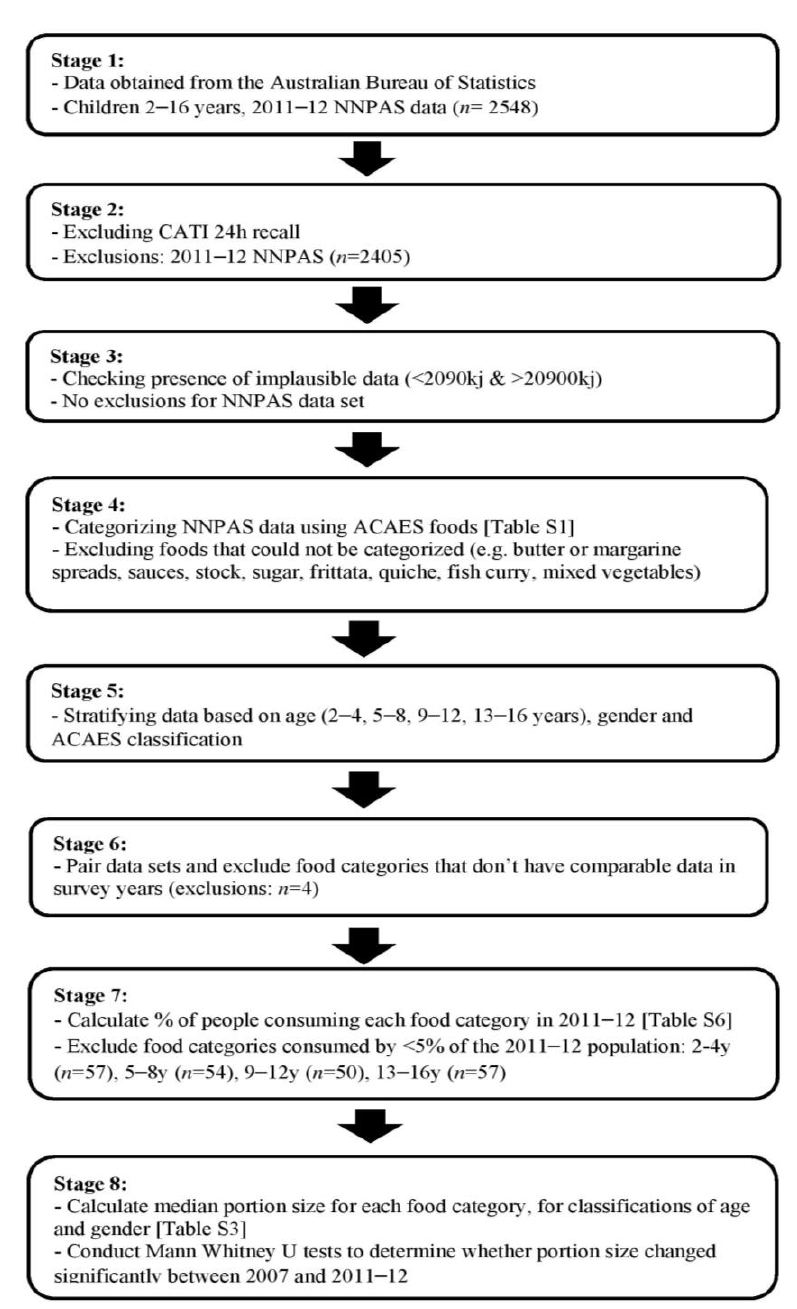
Figure 1. Flow chart describing data manipulation process of the 2011–2012 National Nutrition and Physical Activity Health Survey (NNPAS) data. ACAES: Australian Child and Adolescent Eating Survey.